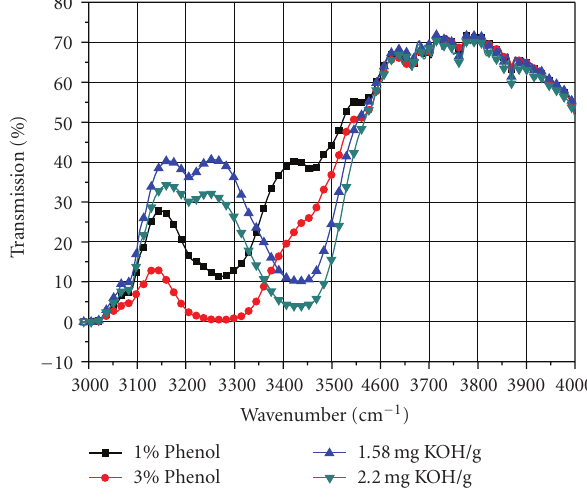
Figure 7: FTIR spectra of acid/phenol contaminated HyJet V. Optical path length: 0.2